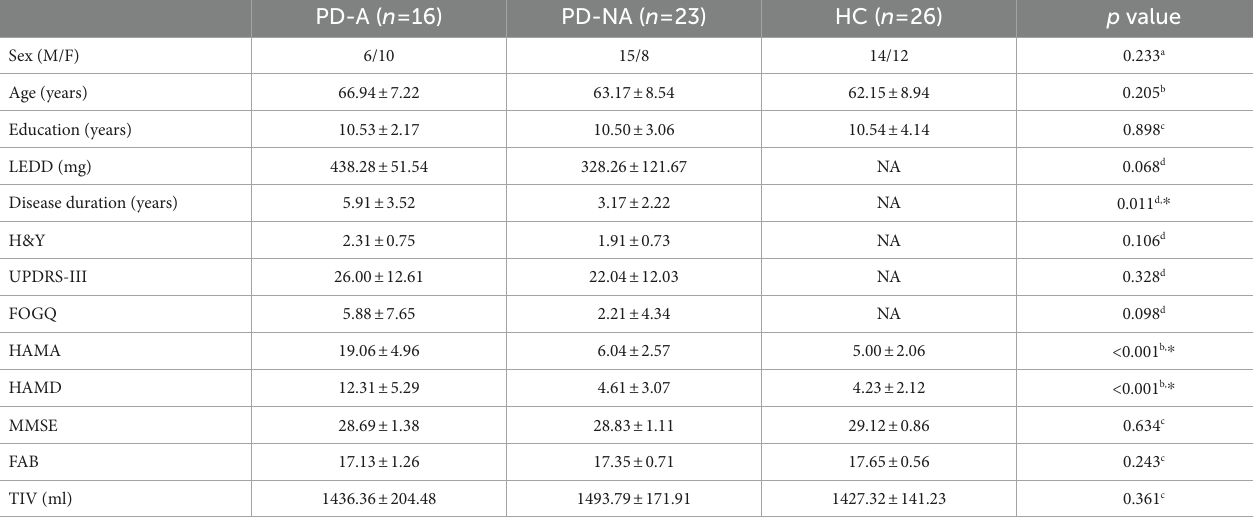
TABLE 1 Comparison of demographics and clinical characteristics among the PD-A, PD-NA and HC